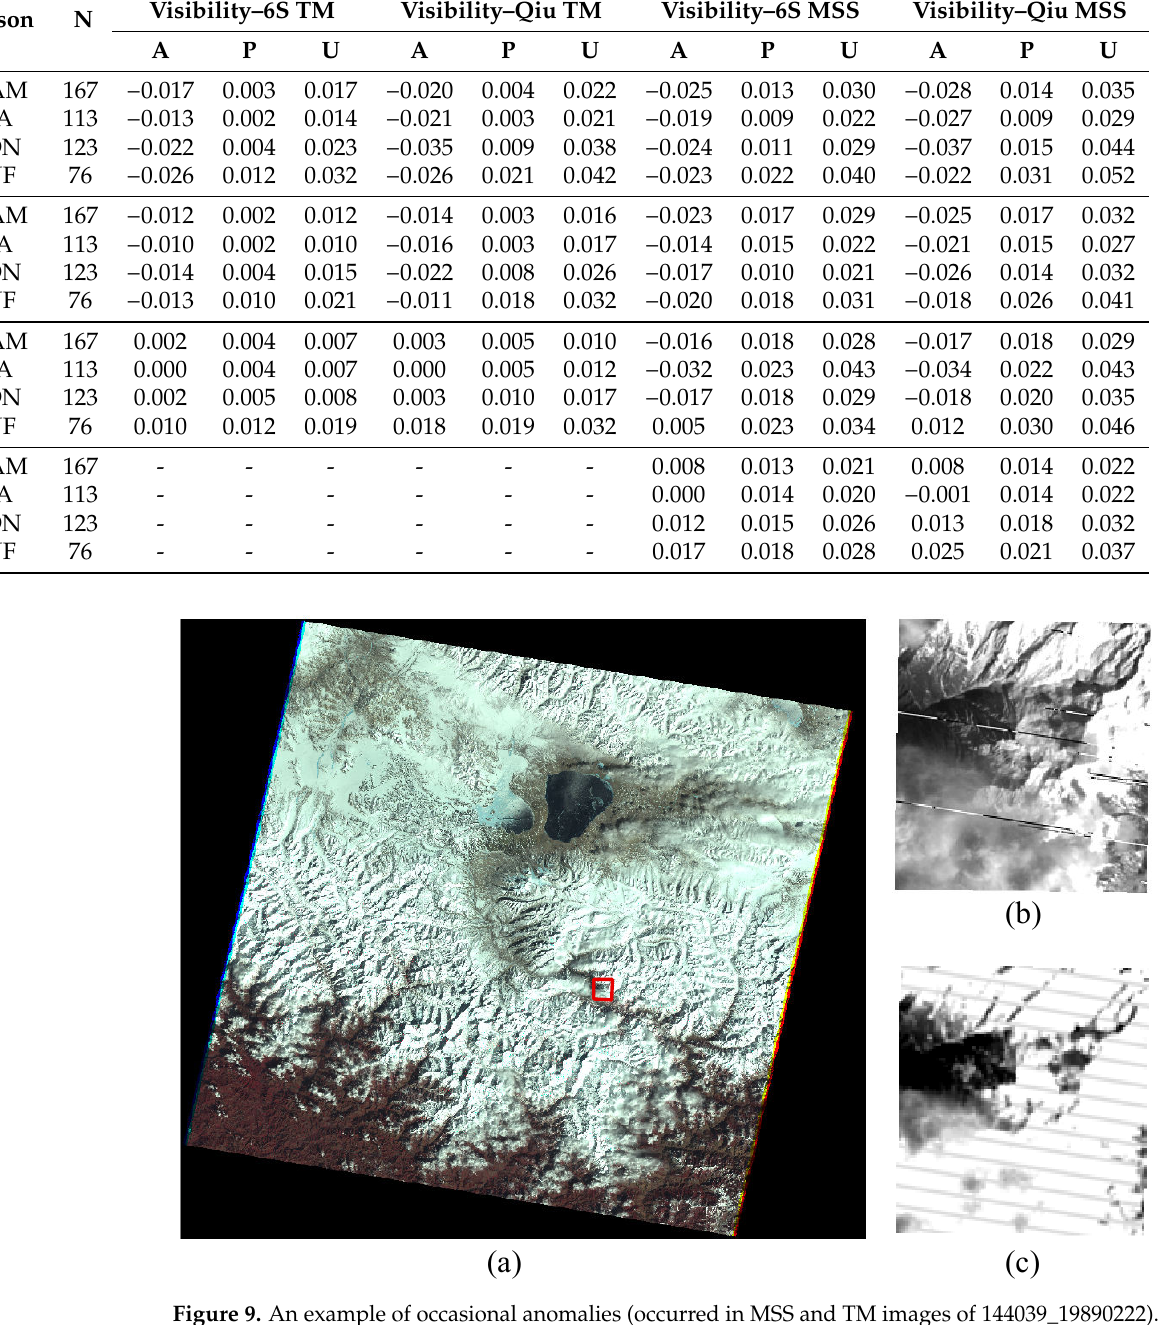
Figure 9. An example of occasional anomalies (occurred in MSS and TM images of 144039_19890222). ( a ) False-color synthesis of Landsat 5 TM RGB composite (red: B4, green: B3, blue: B2). ( b ) An example of detector failure of Landsat 5 TM Band 4 (NIR band). ( c ) An example of detector striping and oversaturation of Landsat 5 MSS and 3 (NIR-1